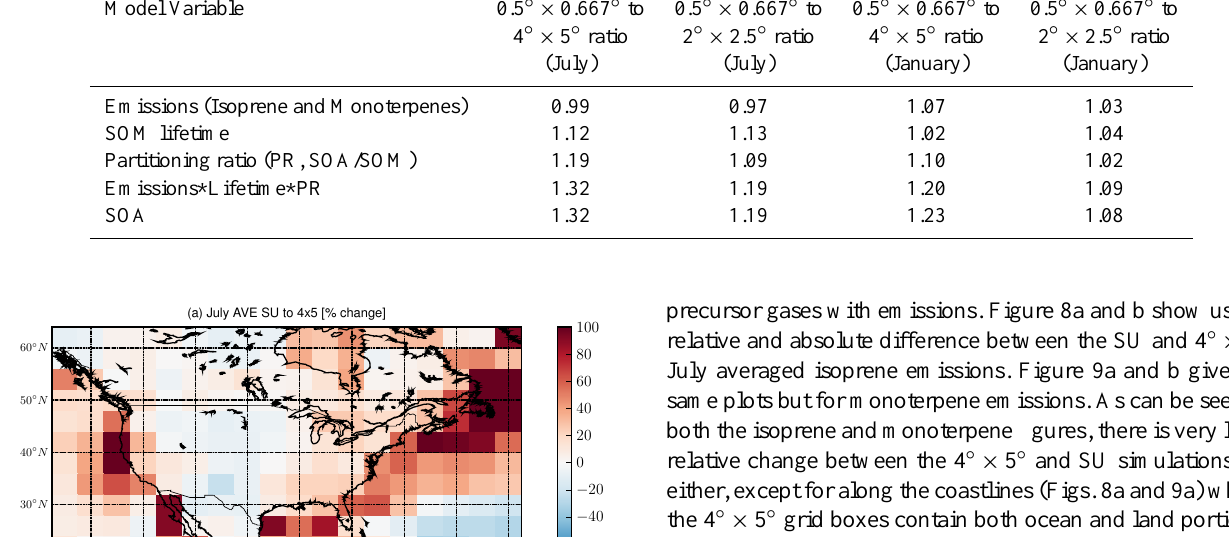
Table 1. The ratios of SOA and SOM properties between the 0.5 ◦ × 0.667 ◦ and 4 ◦ × 5 ◦ simulations over North America. Model Variable